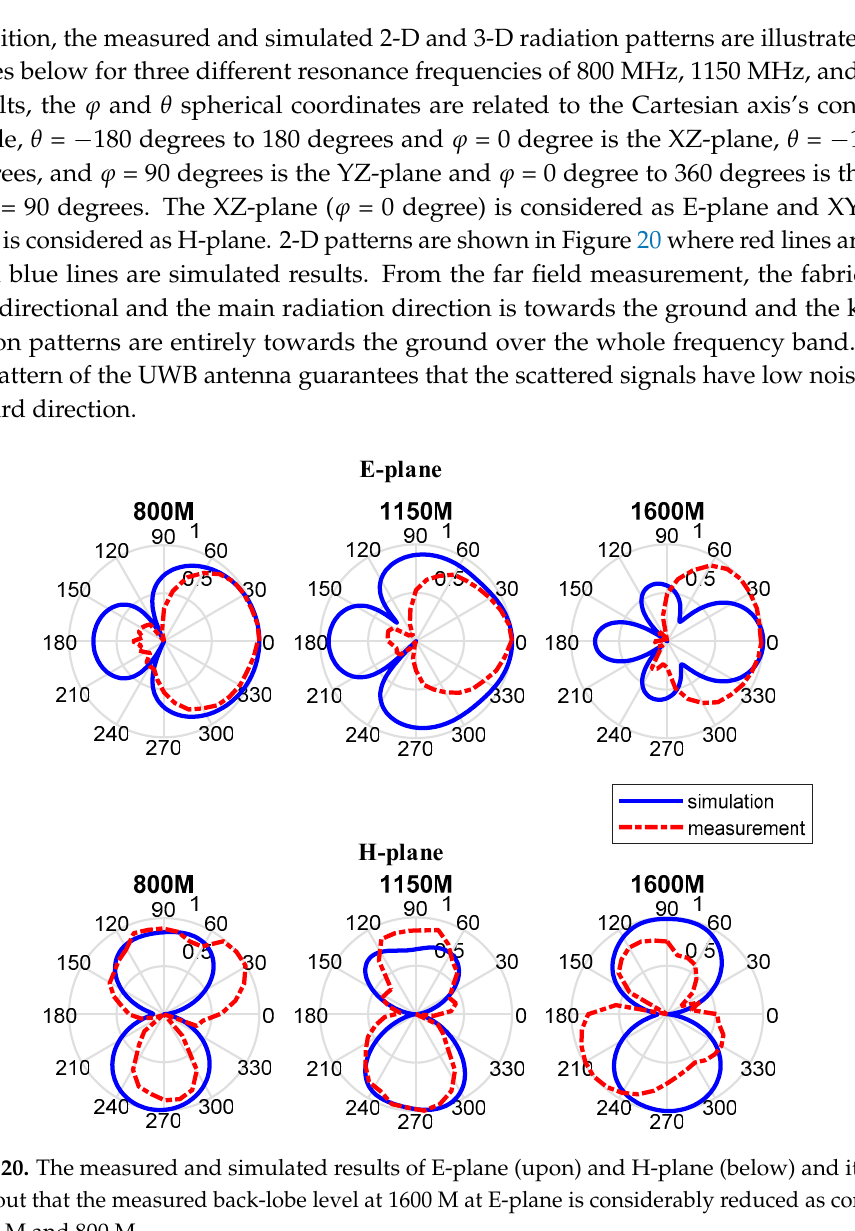
Freq. (GHz) Figure 19. Radiation efficiency over working frequency. Figure 19. Radiation efficiency over working frequency.